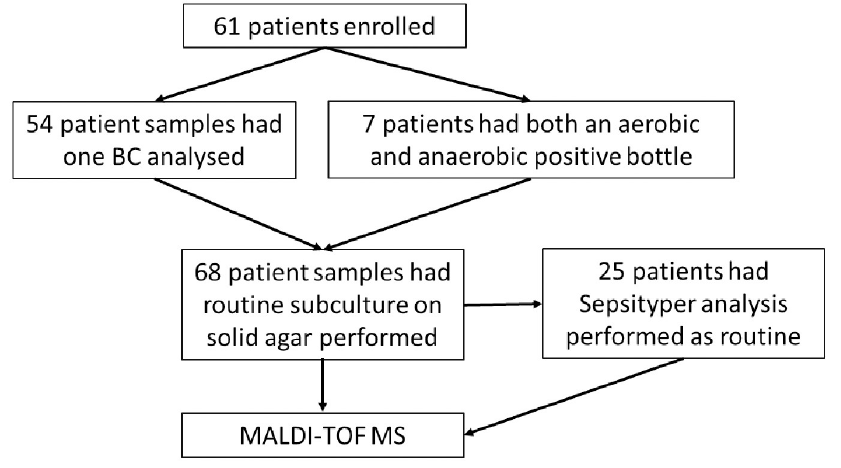
Fig 2. Overview of clinical microbiology